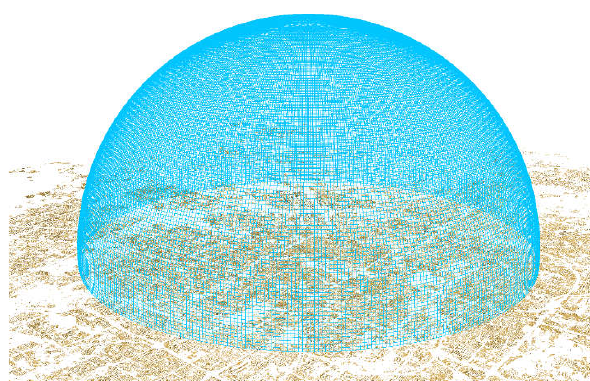
Figure 9 The view space and projection surface of The Lama